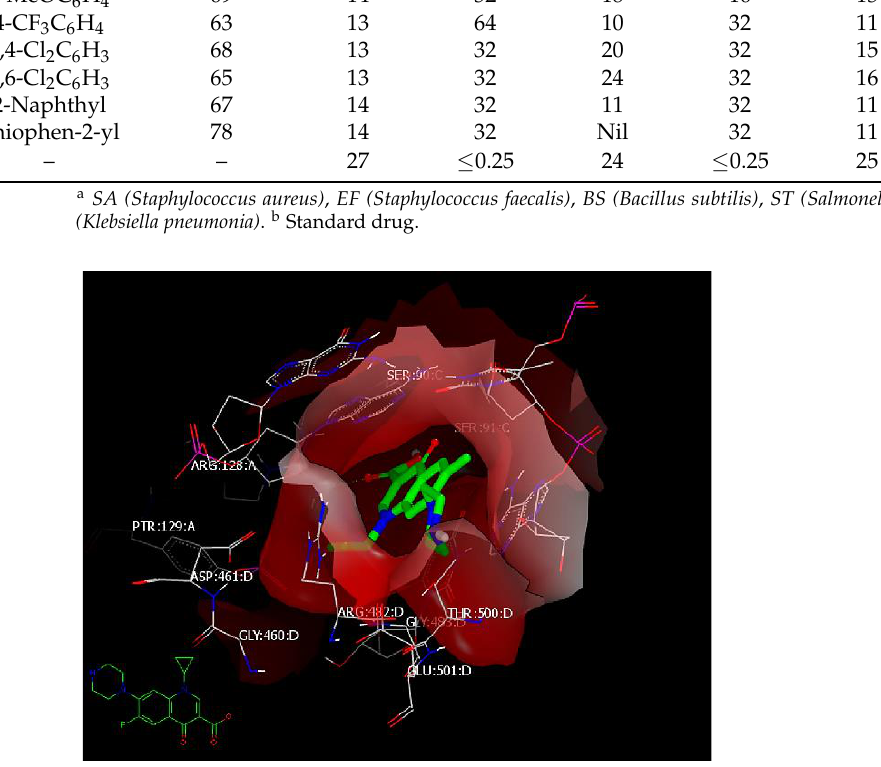
Figure 5. Visual representation of ciprofloxacin docked with 5BTC, showing hydrophobic – hydrophobic interaction and hydrogen bonding with ARG 128:A, as shown by Vida. Image adapted from Elshaier et al. [65].